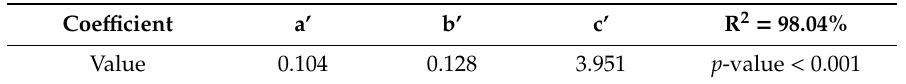
Table 6. Regression parameters of Equation (17) for the Circular Traveling Task (CTT). (Speed [cm / s]; A = 2 ∗ π ∗ r [cm]; W [cm]).